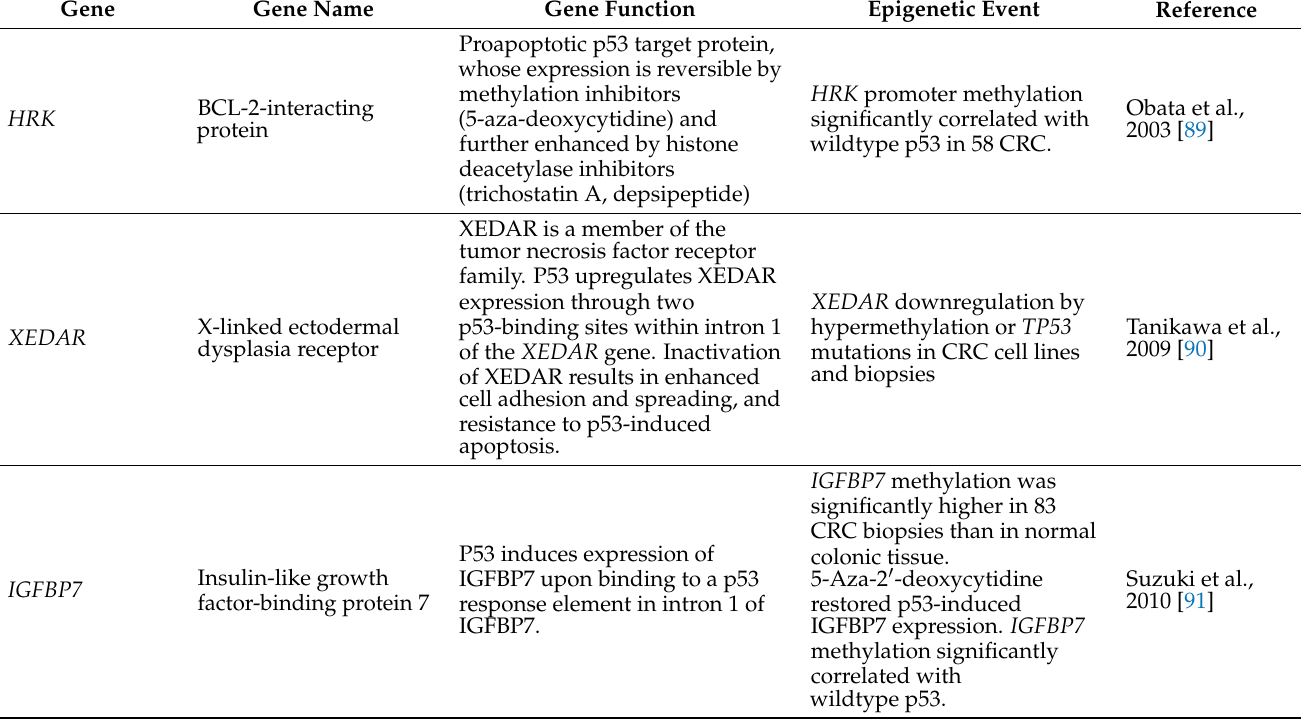
Table 4. Epigenetic alterations downstream of